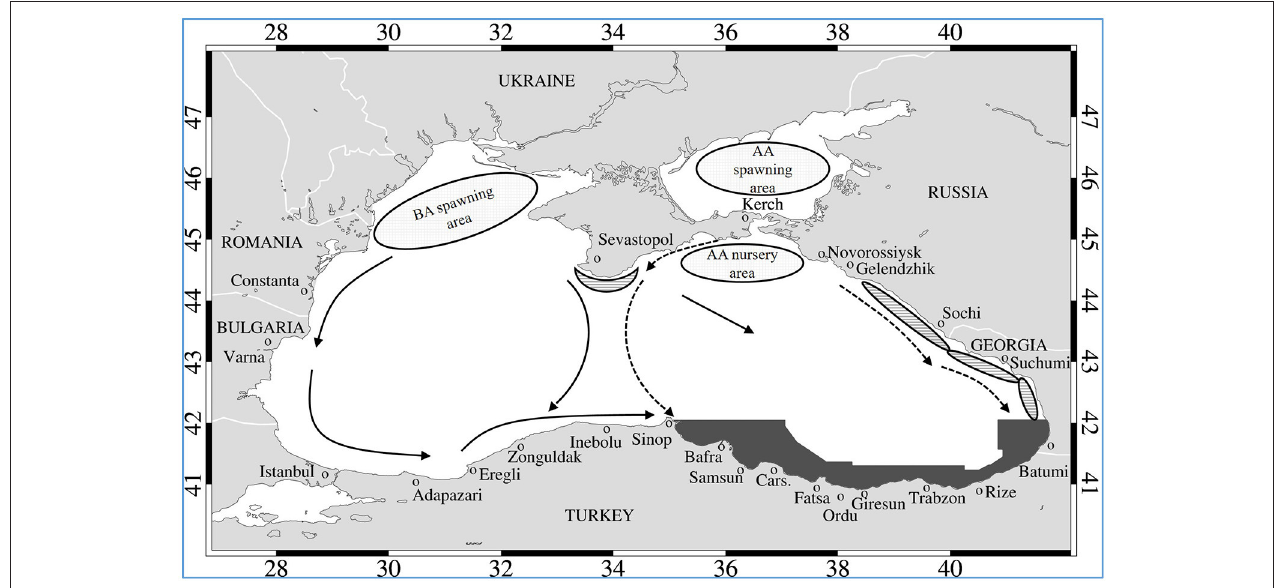
FIGURE 1 | Conceptual figure of Azov anchovy (AA) and Black Sea anchovy (BA) spawning and foraging regions, fall migration paths (indicated by arrows) and overwintering grounds (hatched ovals along Russian and Georgia coasts, as well as the Crimean Peninsula–AA anchovy and gray shaded area–BS anchovy). Redrawn combining concepts of Ivanov and Beverton (1985) and Chashchin (1996).